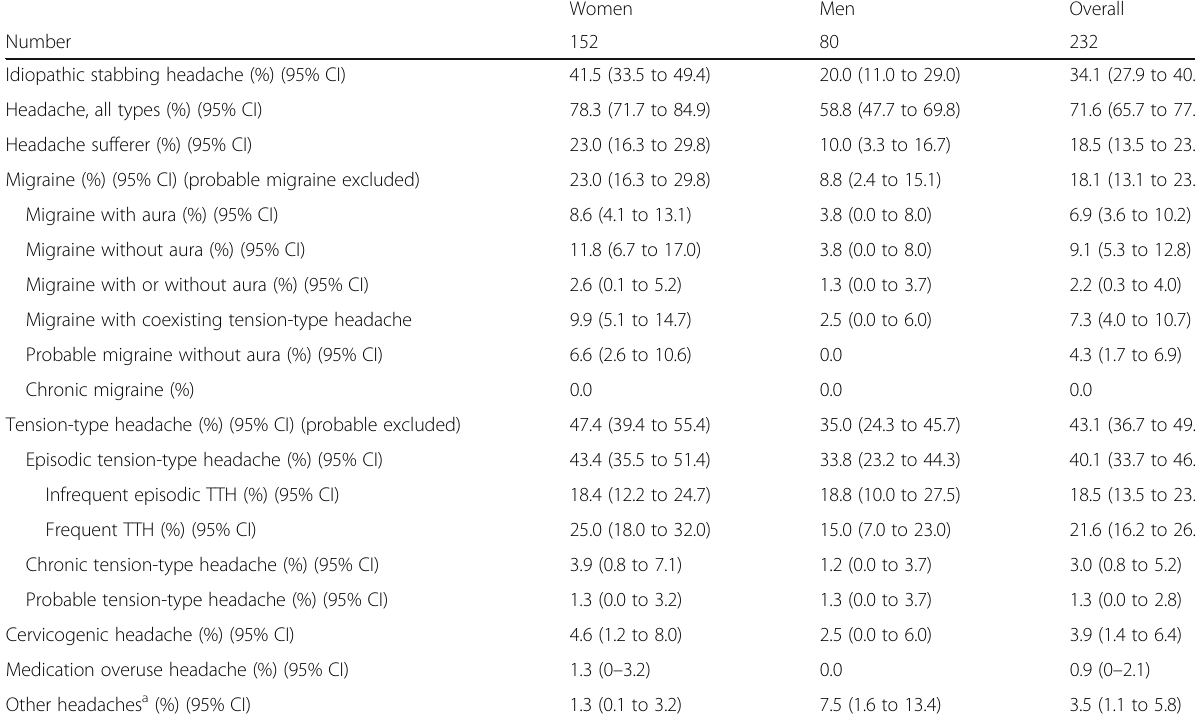
Table 2 1-year prevalence of different headache types ( n = 232). Some participants may have more than one headache